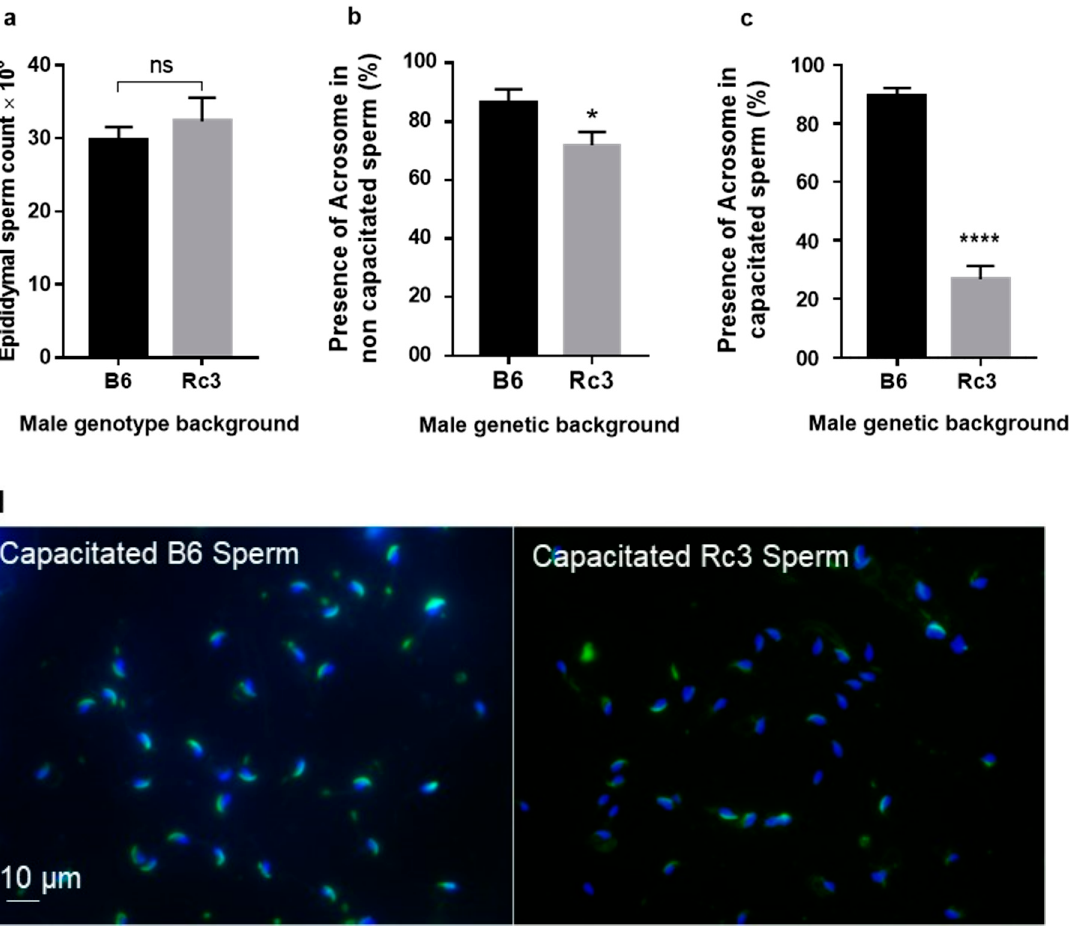
Figure 5. ( a ). Evaluation of epididymal sperm count on B6 and Rc3 using Malassez slide. Estimation of the percentage of the presence of acrosome on non-capacitated ( b ) and capacitated ( c ) B6 and Rc3 epididymal sperm. ( d ) As shown in these illustrative slides, for this analysis, nuclei were stained with DAPI (blue) and the acrosomal region with PSA-FITC (green). ns: non significant, * p = 0.03, **** p <